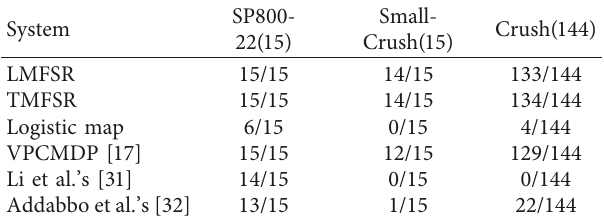
Table 2: Success comparison of TestU01 results of